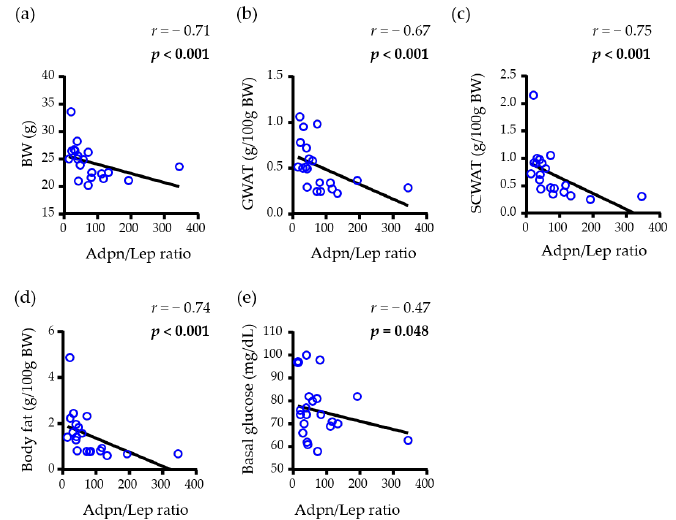
Figure 5. Univariate analysis of the correlations between the adiponectin/leptin (Adpn/Lep) ratio with ( a ) body weight (BW), ( b ) gonadal (GWAT), ( c ) subcutaneous (SCWAT) and ( d ) whole-body fat content of female animal, together with the basal glucose ( e ). Adpn/Lep ratio, adiponectin/leptin ratio; BW, body weight; r , Pearson correlation coefficient; p , significance value. p values lower than 0.05 are highlighted with bold